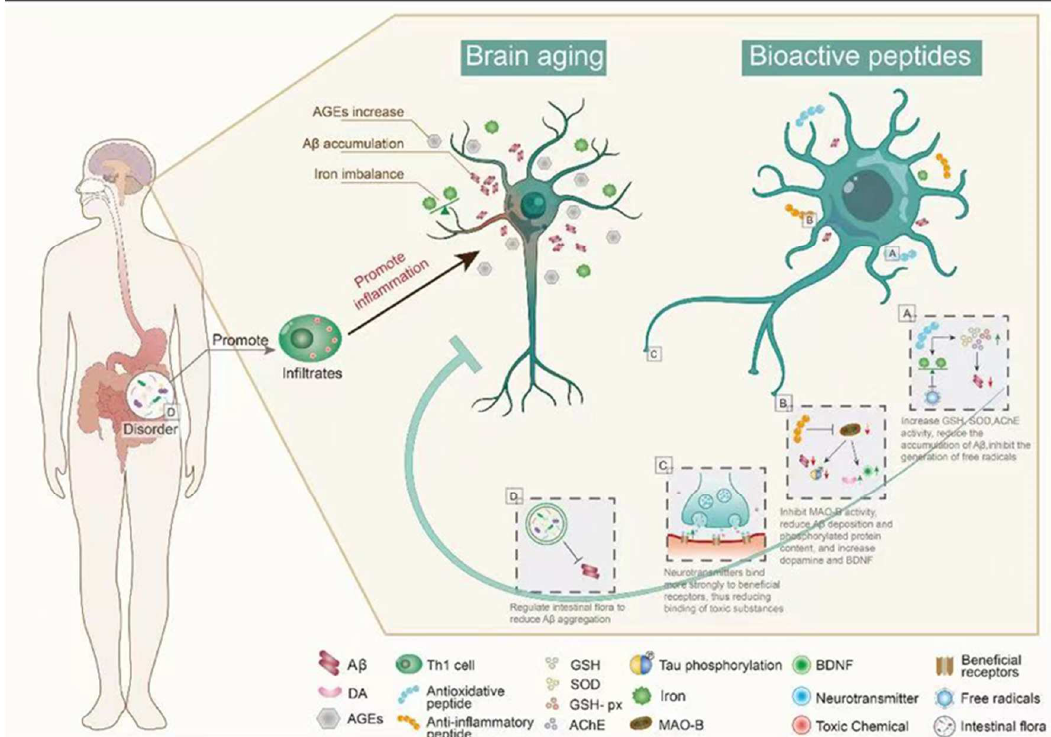
Figure 2. The main mechanism of bioactive peptides in delaying brain aging. ( A ) Bioactive peptides reduce Aβ accumulation by regulating oxidative stress. ( B ) The bioactive peptides inhibit the activ- ity of MAO-B, up-regulate BDNF, and reduce the aggregation of Aβ. ( C ) Bioactive peptides